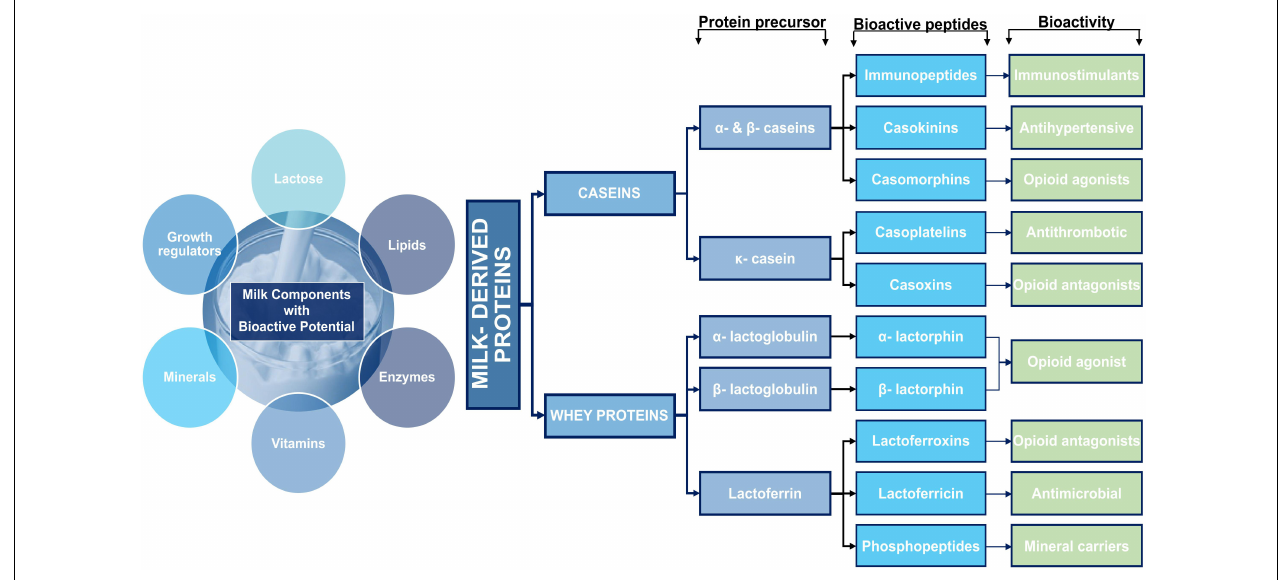
FIGURE 3 | Major milk components with bioactive